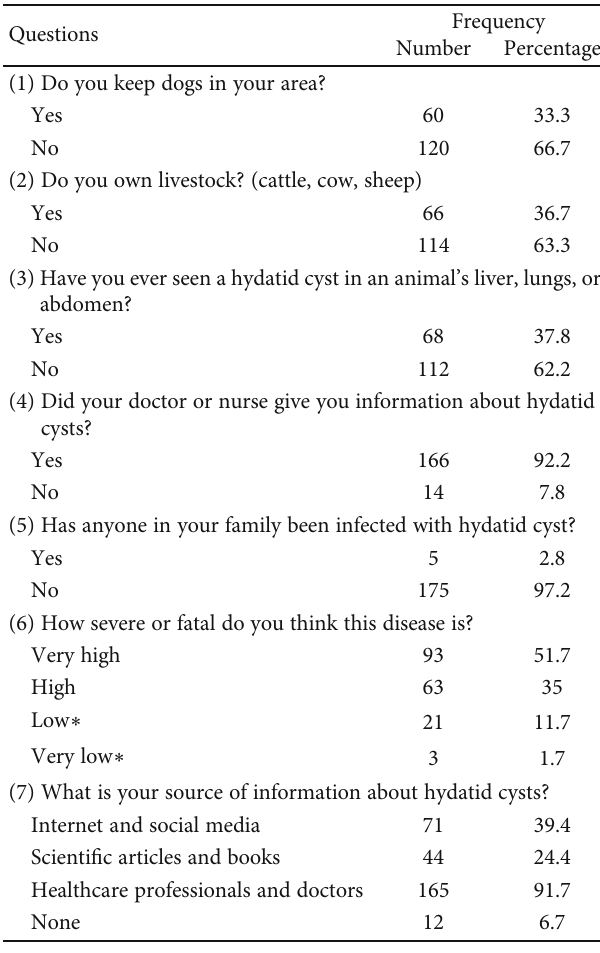
Table 3: Linear regression analysis of factors associated with KAP among participants with a history of hydatid cyst surgery.